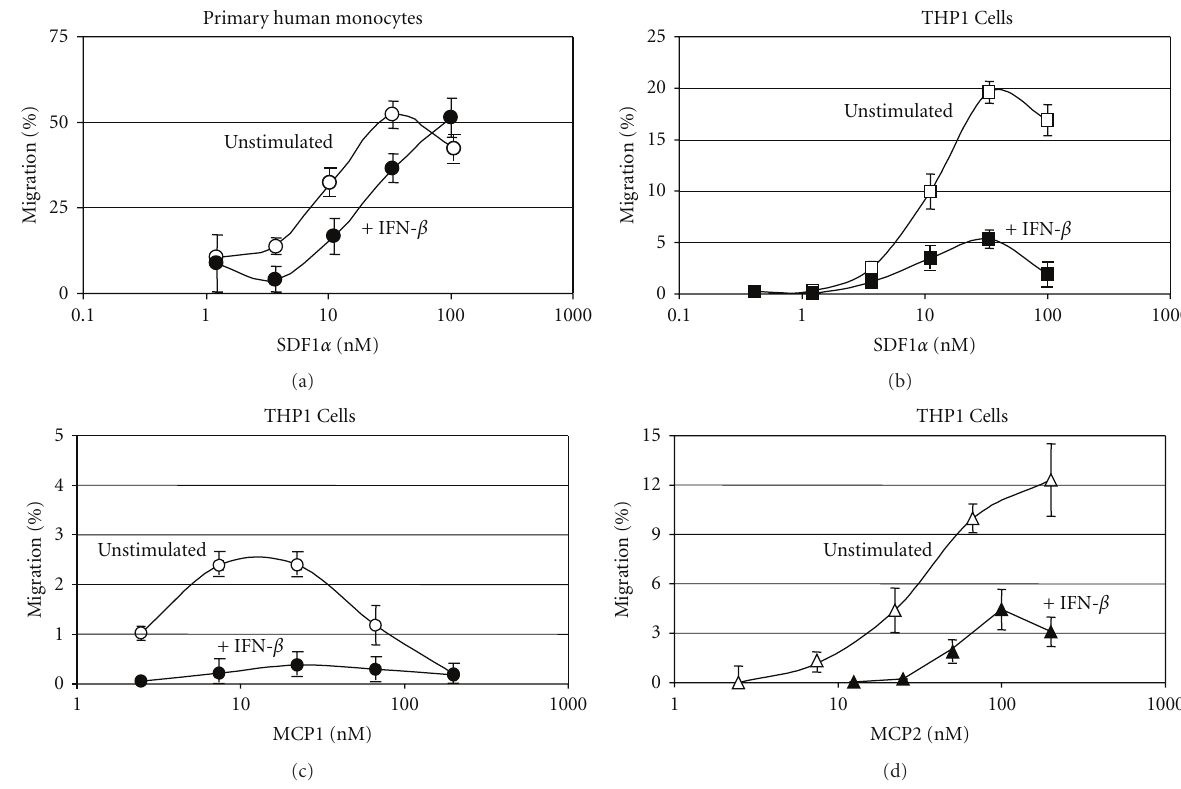
Figure 7: E ff ect of IFN- β on chemokine-dependent migration of monocytes . Monocyte transmigration across an artificial barrier in response to chemokine stimulation was determined as described in Section 2. Primary monocytes incubated with IFN- β (1000IU/10 7 cells) for 20 hours were stimulated with various concentrations of SDF1 α (Figure 7(a)). IFN- β -stimulated (dark circles) and unstimulated (open circles) cells are shown.The concentrationof SDF1 α (nM SDF1 α ) isshownon the x -axis alongwith transmigration,aspercent (% migration) of cells applied, on the y -axis. The monocytic cell line THP-1 was incubated with IFN- β (1000IU/10 7 cells) for 20 hours and then stimulated with increasing concentrations of either SDF1 α (Figure 7(b)), MCP1 (Figure 7(c)), or MCP2 (Figure 7(d)). The concentrations of SDF1 α , MCP1, and MCP2 are shown on the x -axis (nM chemokine) and results are presented as percent of total cell migration (% migration). Data represents mean ± SD of n =